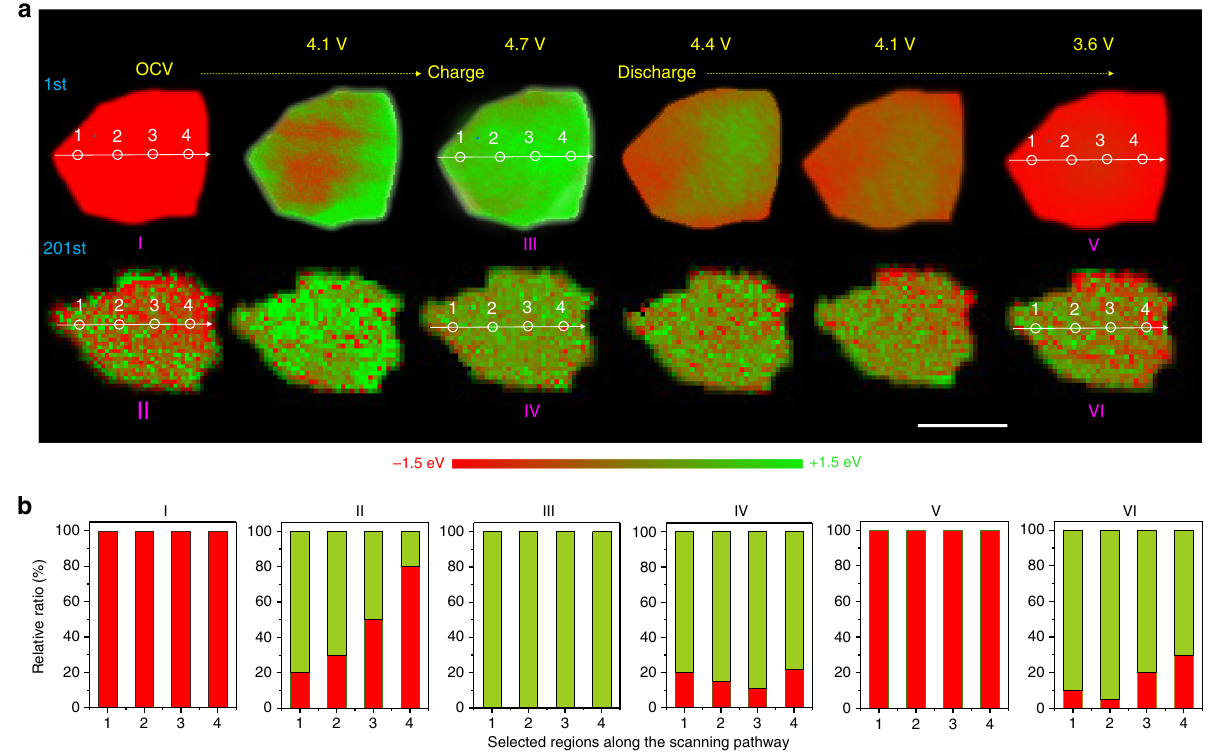
Fig. 4 Spatial-resolved electrochemical evolution after the 1st and 201st cycle. a Operando 2D chemical phase mappings at the Ni K-edge of NCM particles during the fi rst and 201st cycles. Scale bars 2 μ m. 1st (I, pristine; III, 4.7 V; V, 3.6 V), and 201st cycle (II, pristine; IV, 4.7 V; VI, 3.6 V), b Quanti fi cation of the selected positions in 2D TXM-XANES phase mappings (Red represents discharge state, green represents charge